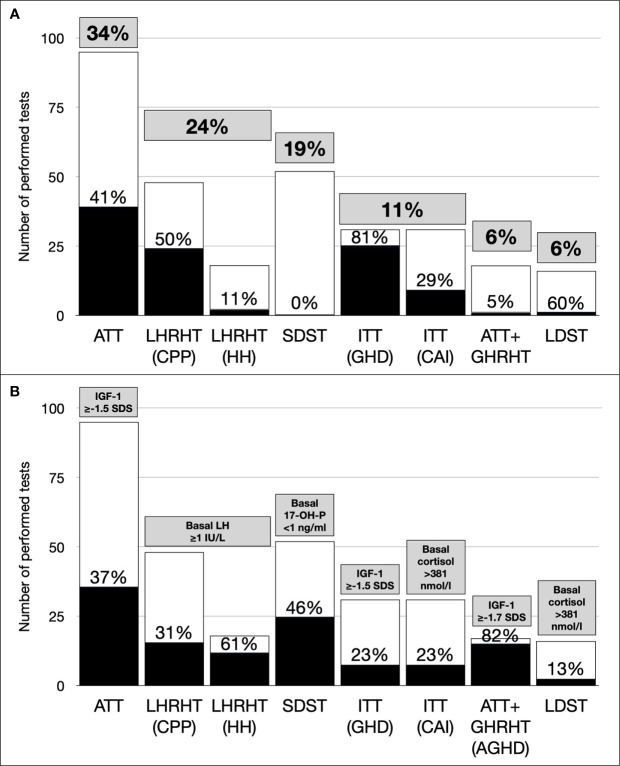

(A) Distribution of performed and pathological tests (grey boxes: prevalence on overall tests; dark bars: prevalence of pathological findings for each test). (B) Distribution of spared tests using single hormone determination (gray boxes, used cut-offs; dark bars, prevalence of saved tests for each test). 17-OH-P, 17-hydroxy-progesterone; AGHD, Adult Growth Hormone Deficiency; ATT, Arginine Tolerance Test; CAI, Central Adrenal Insufficiency; CPP, Central Precocious Puberty, GHD, Growth Hormone Deficiency; GHRHT, Growth Hormone Releasing Hormone Test, HH, Hypogonadotropic Hypogonadism; IGF-1, Insulin Growth Factor-1; ITT, Insulin Tolerance Test; LDST, Low Dose Synacthen Test; LH, Luteinizing Hormone; LHRHT, Luteinizing Hormone Releasing Hormone Test; NC-CAH, Non-Classical Congenital Adrenal Hyperplasia; SDS, Standard Deviation Score; SDST, Standard Dose Synachten Test.